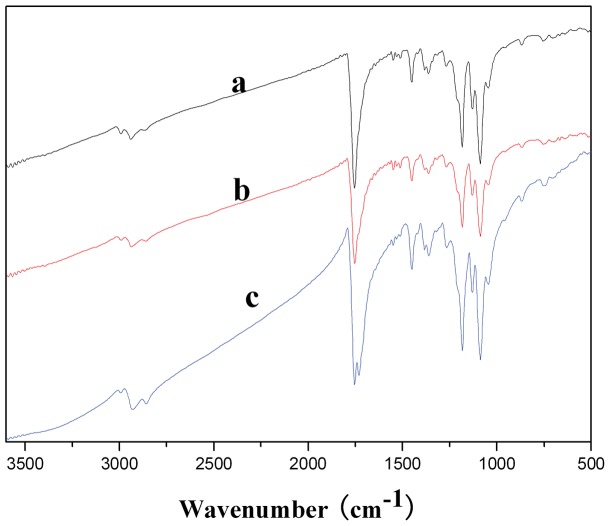
FTIR spectra of different NFS: (a) 3/1 NFS, (b) 2/1 NFS, and (c) 1/1 NFS.The 1/1 ratio NFS group exhibited carbonyl stretching (C = O) at 1754 cm−1 (due to PLLA) and 1731 cm−1 (due to PCL), while other NFS group gave a single peak at 1754 cm−1.